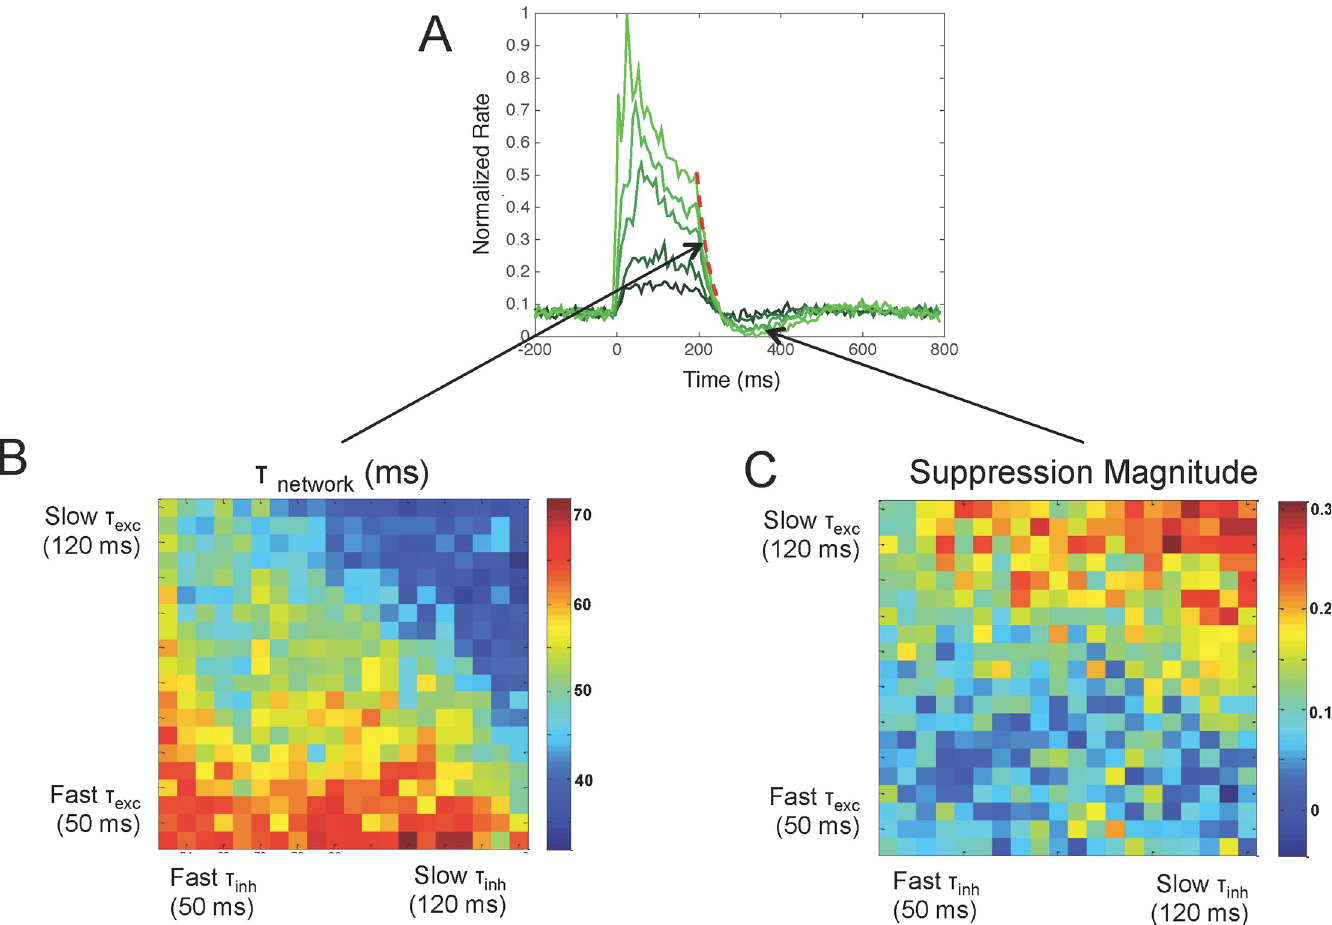
Fig 4. After-suppression depends on local network properties. A) Shown is an example response profile of facilitated neurons to optogenetic stimulation. We modeled the decay to baseline with an exponential function and computed the absolute magnitude of suppression relative to baseline and used these values for Fig 4B and 4C. B) We found that the decay to baseline was faster when excitatory and inhibitory time constants increased (upper right) and slower when excitatory and inhibitory time constants decreased (lower left). C) The magnitude of suppression was also greater for larger excitatory and inhibitory time constants (upper right) compared to small excitatory and inhibitory time constants (lower